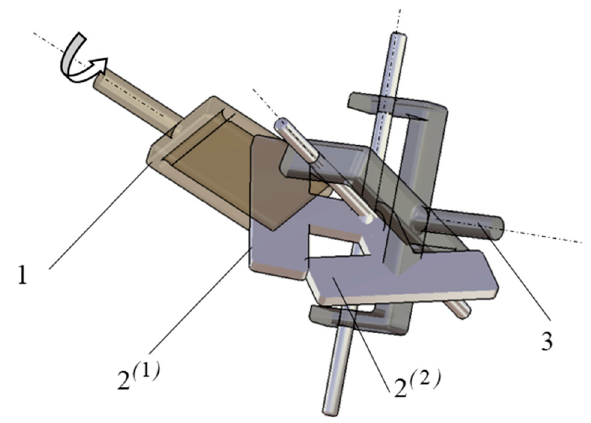
Figure 5. The assemblage possibilities of the mechanism.